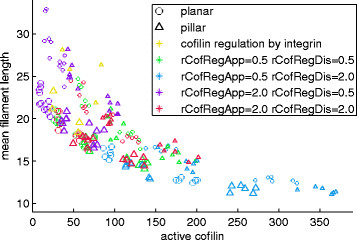
Relation of filament size to amounts of active cofilin and other parameters. Each marker indicates the result of a simulation run with different parameters. Colors denote parameters related to the cofilin activation mechanism, marker types distinguish simulations of pillar structure systems (triangles) and planar surfaces (circles), and larger markers indicate simulations with 200 initial integrin entities vs. 100 for the smaller markers (mostly to be found above the former). More active cofilin thus coincides with shorter filaments.